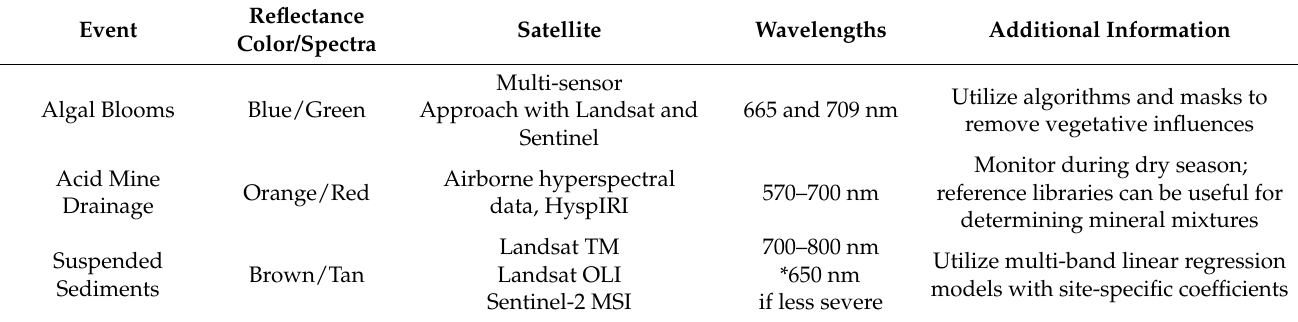
Table 4. Corresponding Wavelengths for Water Quality